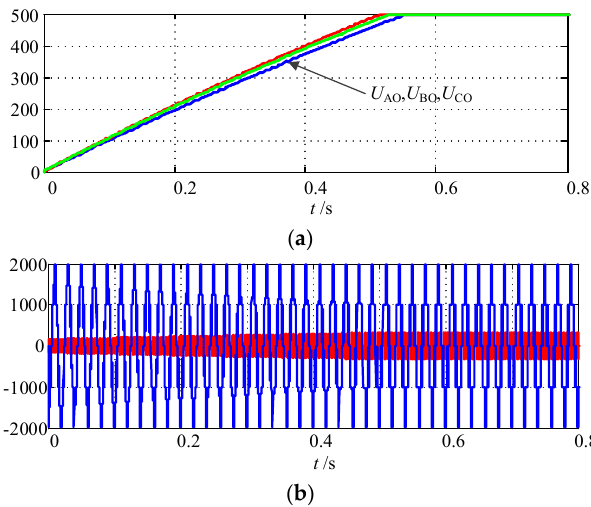
Figure 9. The inverter without capacitor voltage control. ( a ) Midpoint Potential of three phases; and ( b ) Line voltage and common mode voltage.